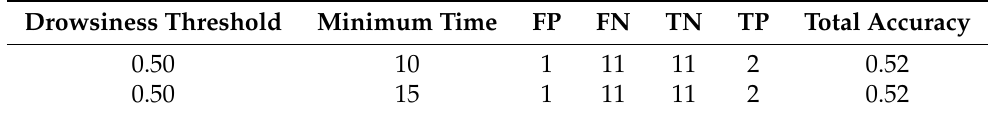
Table 8. Results obtained by Alternative II when using the system over the test data with the best combination of drowsiness _ threshold and min _ time